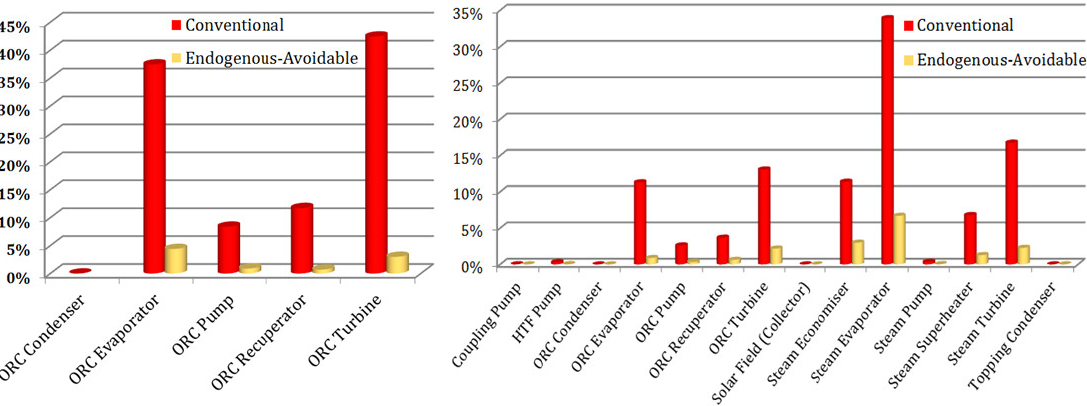
Figure 12. Comparisons of the conventional and advanced analysis from an exergo-economic perspective (in the GPP and SGPP).